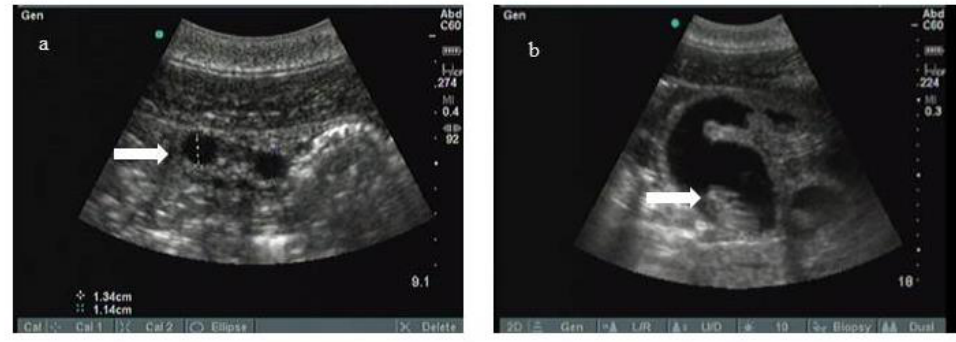
Figure 2. Animal 6 ultrasound. a) white arrow points to pre-ovulatory follicle, b) white arrow points to fetus.